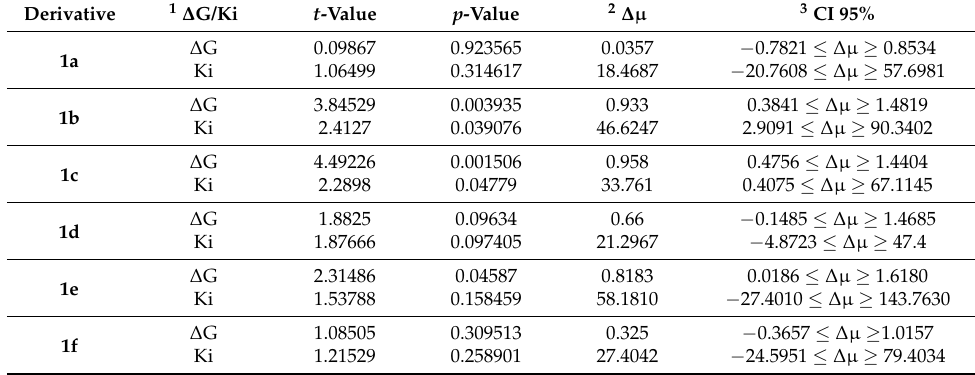
Table 2. Statistical analysis of the inhibitory activity of the derivatives 1a – f against closed-conformation of bacterial AKs (2RGX, 3HPQ, 4NU0, 1P3J, 1ZIP, 1S3G) and eukaryotic AKs (1Z83, 2C95, 2C9Y, 2BBW, 2BWJ/chain B).